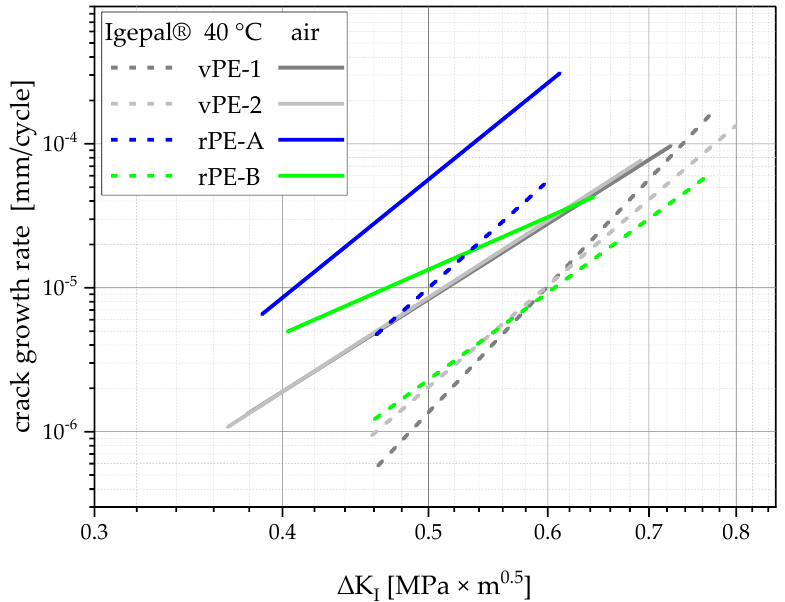
Figure 12. Linear fits of crack-growth kinetics tested at 40 °C for all materials in a solution of deionized water and 10 m% Igepal CO-630 (dashed lines) and in air (full lines).